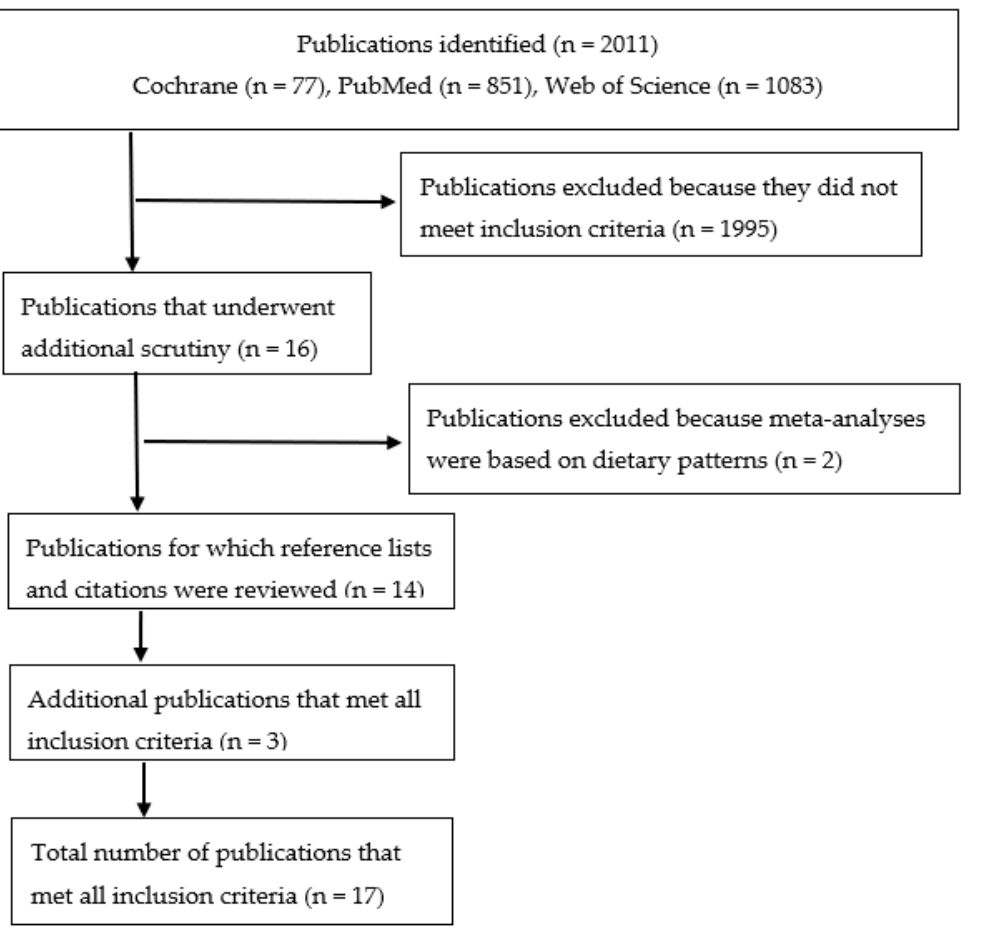
Figure 1. Flow chart of publication selection (see text for further details on search terms and filters used).